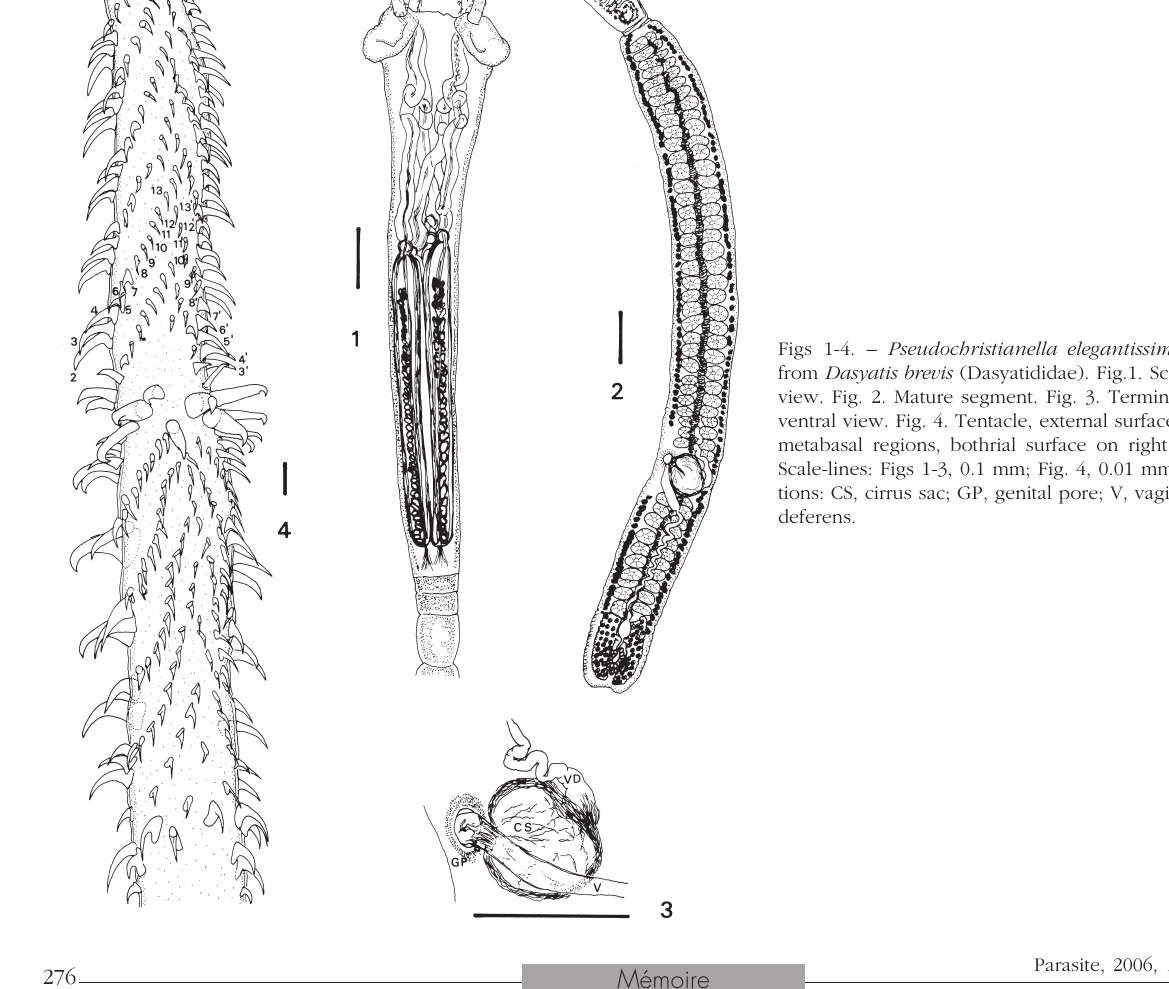
Figs 1-4. – Pseudochristianella elegantissima sp. nov. from Dasyatis brevis (Dasyatididae). Fig.1. Scolex, lateral view. Fig. 2. Mature segment. Fig. 3. Terminal genitalia, ventral view. Fig. 4. Tentacle, external surface, basal and metabasal regions, bothrial surface on right hand side. Scale-lines: Figs 1-3, 0.1 mm; Fig. 4, 0.01 mm. Abbrevia- tions: CS, cirrus sac; GP, genital pore; V, vagina; VD, vas